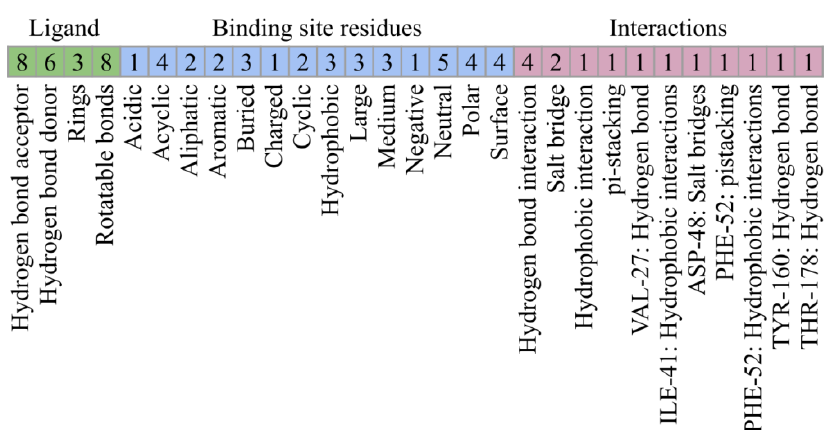
Figure 5. Interaction profile for the inhibition of Tc DHFR-TS. Interaction features describe three different aspects of protein-ligand interactions.